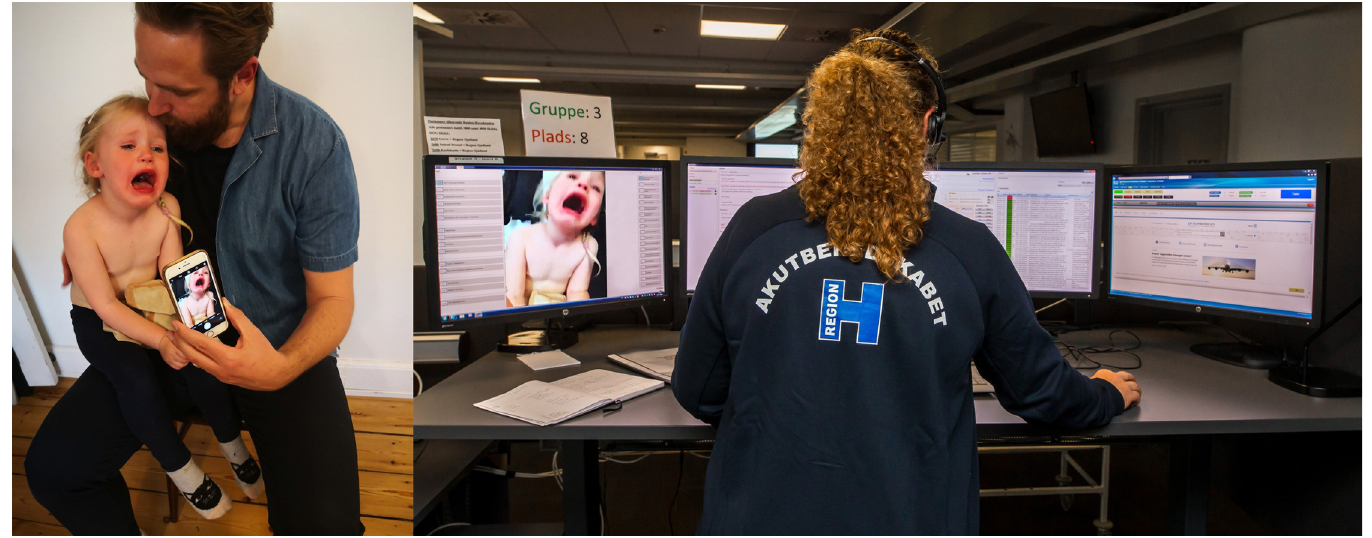
Fig 1. Parent streaming video to call-handler at MH1813. MH1813: Medical Helpline 1813.